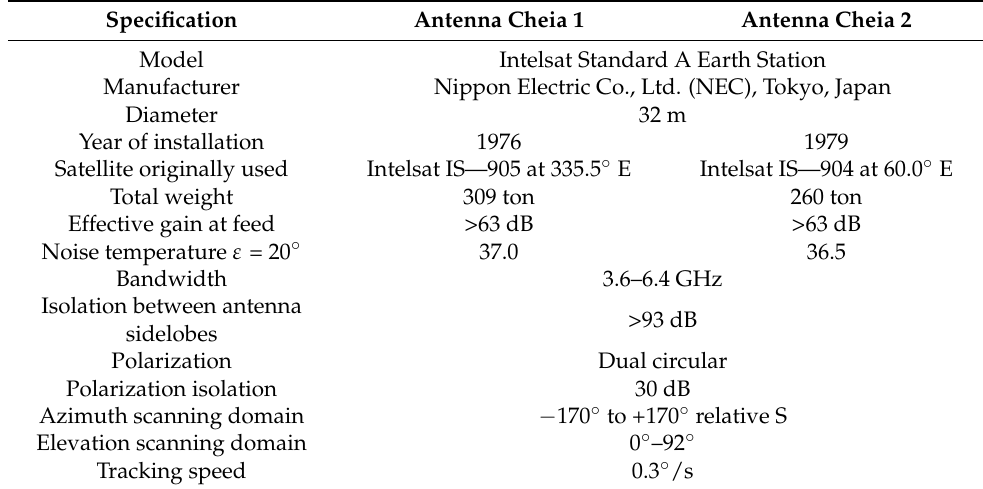
Table 1. Main technical specifications of antennas in Cheia Communications Center.